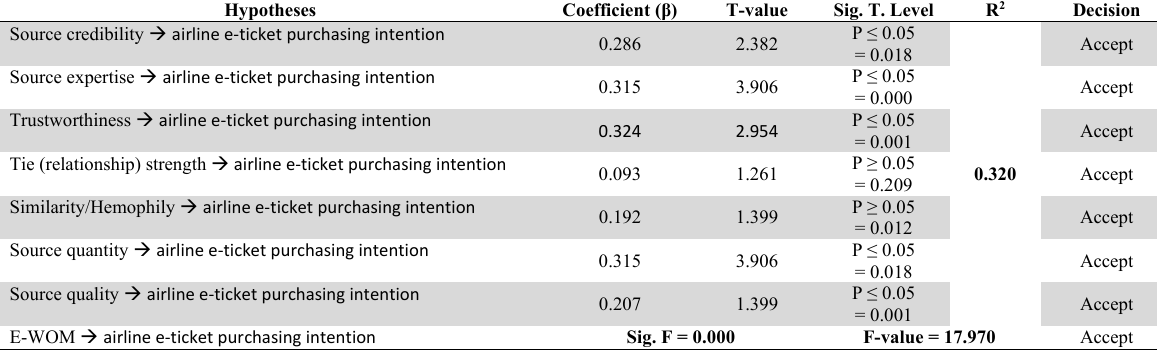
The Results of the first